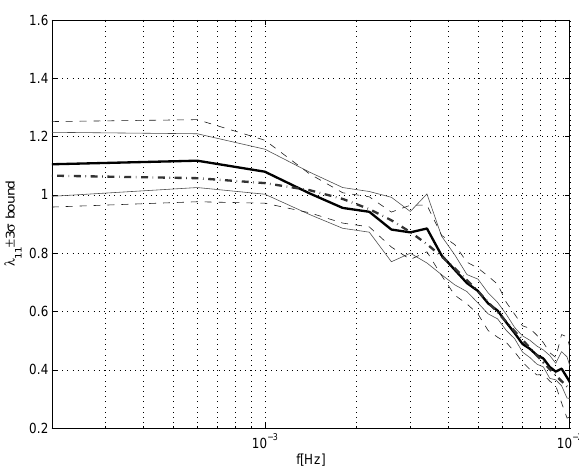
Figure 8: Real parts of ˆ λ 11 and ± 3 σ λ LPM-FM of the simulated case with mul- tisine excitation. Black: ˆ λ 11 . Gray (- -): ˆ λ 11 ± 3 σ λ 11 uncertainty bounds caused by noise. light Gray: ˆ λ 11 ± 3 σ λ bounds caused by nonlinear distortions. dark Gray (- · ): λ 11 calculated based on G lin